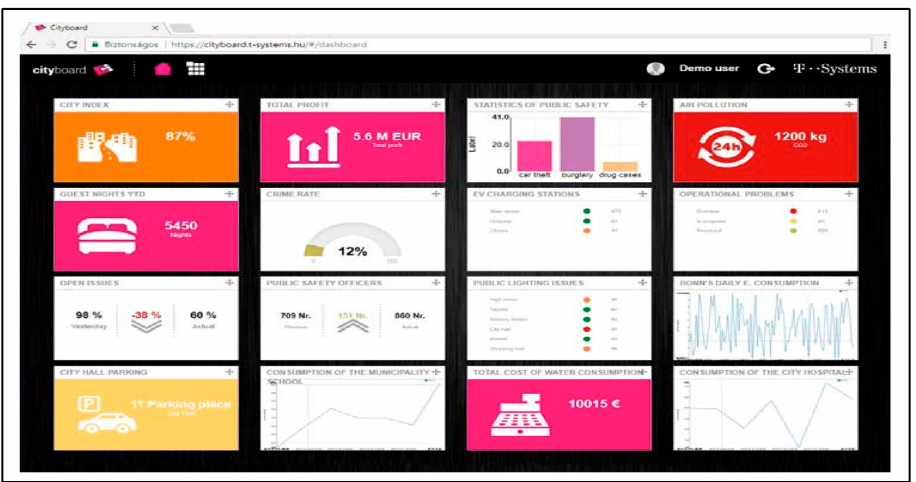
Figure 6. Smart City Dashboard developed by Deutsche Telekom for Hungary subsidiary, derived from [149].